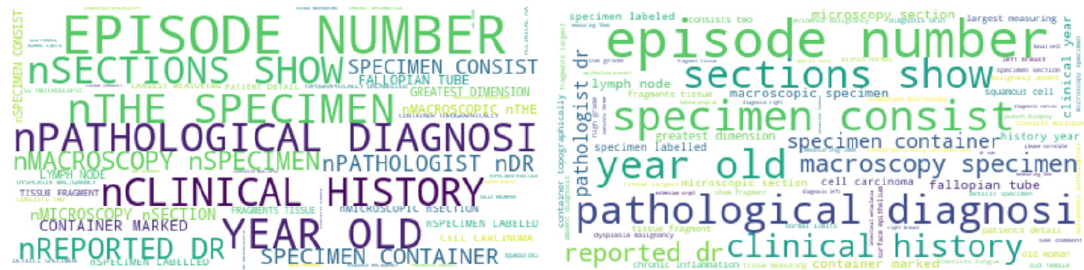
Figure 1. The distribution of character, word count, and unique word count of the histopathology reports before and after pre-processing.